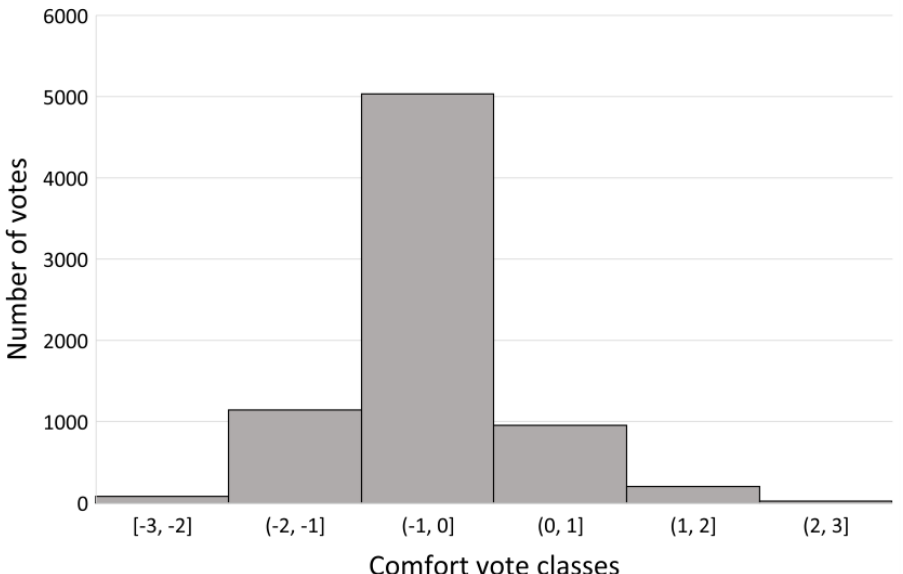
Figure 5. Distribution of the comfort votes collected in the Helios building during the period from July 2018 to June 2019. Figures 6 and 7 show the scatterplot of the thermal comfort votes and the relative temperature ranges for the indoor and outdoor air temperatures. From the graph, it is possible to evaluate the means and standard deviations of the range of temperatures for each perceived comfort vote for the indoor air temperature. This is reported in Table 1. As expected, there is a positive trend between the mean of the indoor and outdoor air temperature and the comfort vote, while the standard deviation values seem to be larger for the central classes, underlining that what the occupants think to be a neutral and comfortable temperature is more subjective than the extreme votes. A quadratic equation was used to interpolate the data and extract a relationship between the votes and the indoor and outdoor temperatures. The equations are reported in Figures 6 and 7.